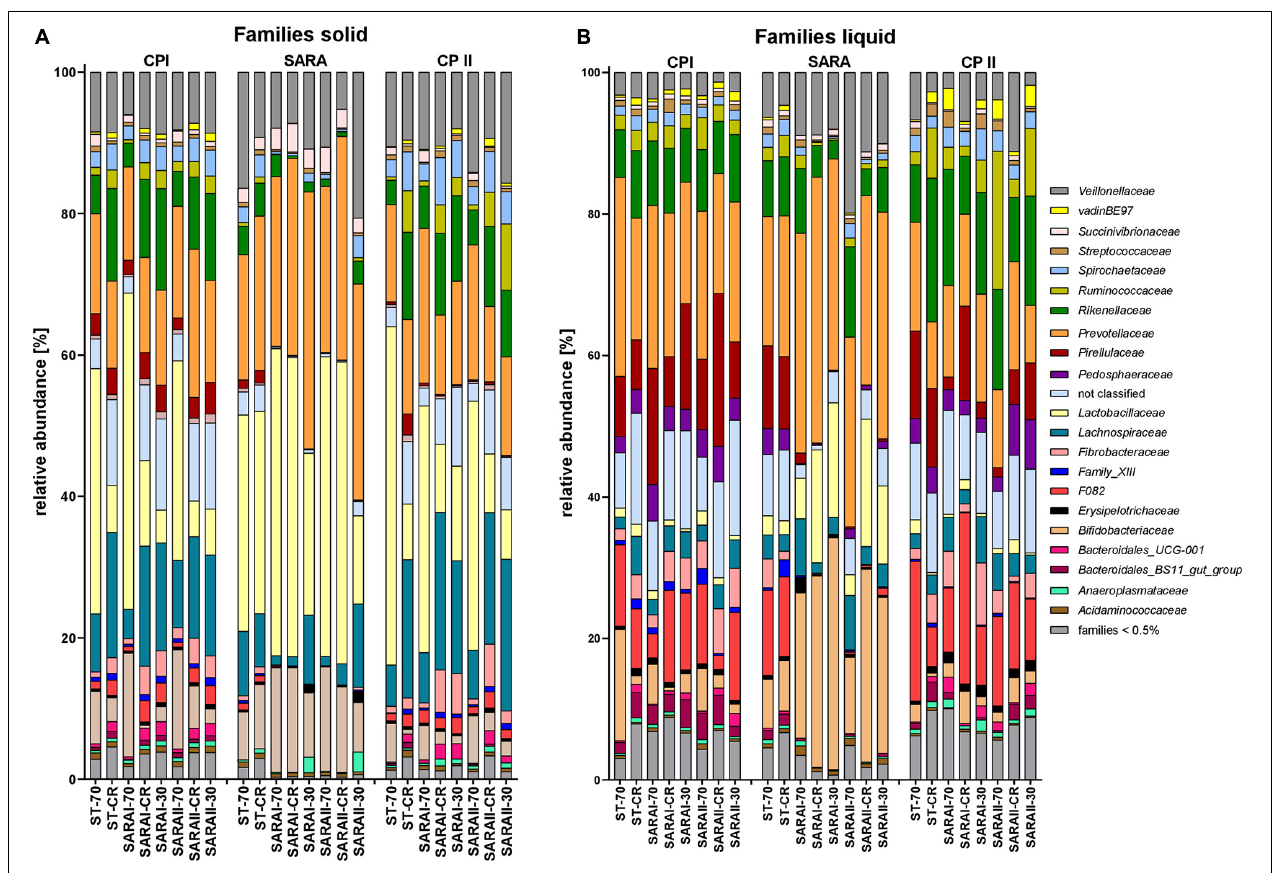
FIGURE 6 | Relative abundances on family level detected by the PacBio amplicon sequencing approach for the solid (A) and liquid (B) phases. Families with an abundance of less than 0.5% were combined into one group. Relative abundances for each treatment group are shown for all three experimental periods (CP I = control period I, SARA = subacute acidosis period, CP II = control period II). Treatment groups are labeled as follows: ST-70 = standard buffer, 70% concentrate; ST-CR = standard buffer, changing ratio; SARAI-70 = SARA I buffer, 70% concentrate; SARAI-30 = SARA I buffer, 30% concentrate; SARAI-CR = SARA I